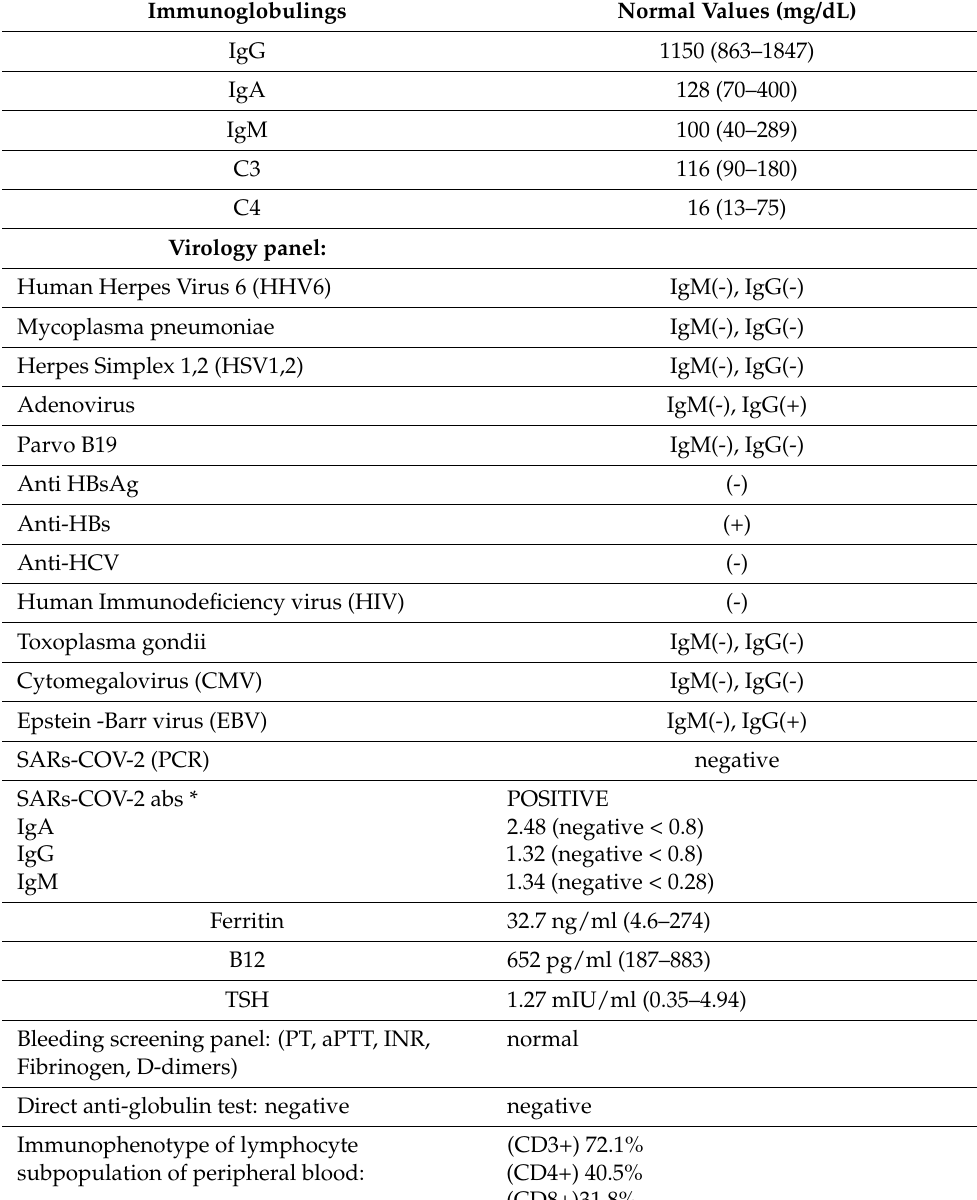
Table 1. Initial laboratory